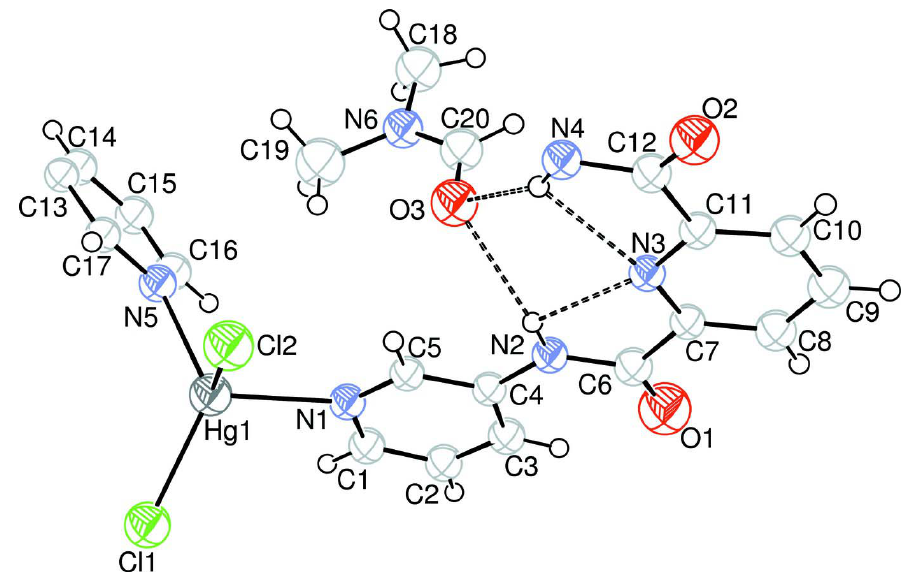
Figure 1 The asymmetric unit of the title molecule, with the atom-numbering scheme. Hydrogen bonds are shown as dashed lines. Bis( µ - N , N ′ -di-3-pyridylpyridine-2,6- dicarboxamide)bis[dichloridomercury(II)] N , N